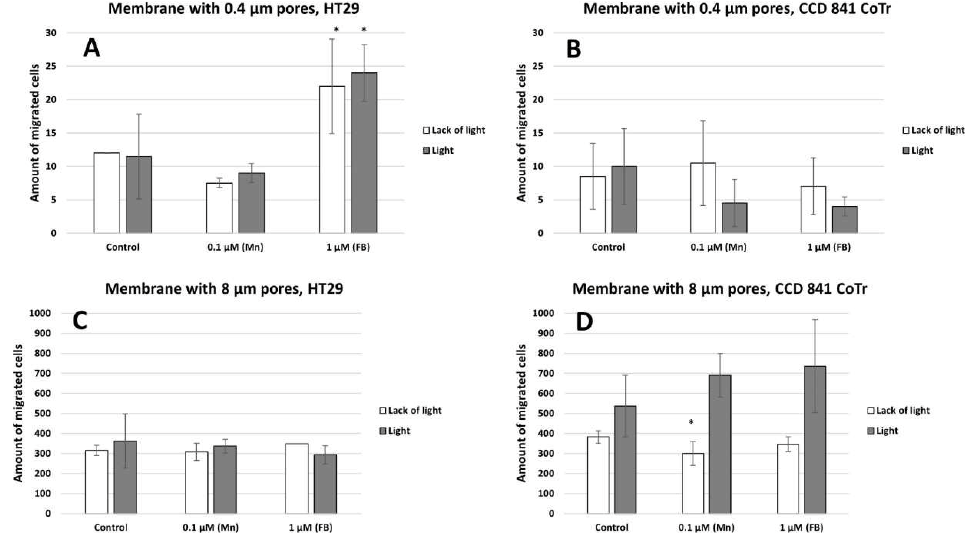
Figure 8. Amount of cells migrated to a membrane with 0.4 µ m pores ( A )—HT29 and ( B )—CCD 841 CoTr, and a membrane with 8 µ m pores ( C )—HT29 and ( D )—CCD 841 CoTr. Columns and bars show the mean ± standard deviation (n = 3). Statistical significance was analysed at p < 0.05. *Statistical significance in comparison to appropriate control at p < 0.05.